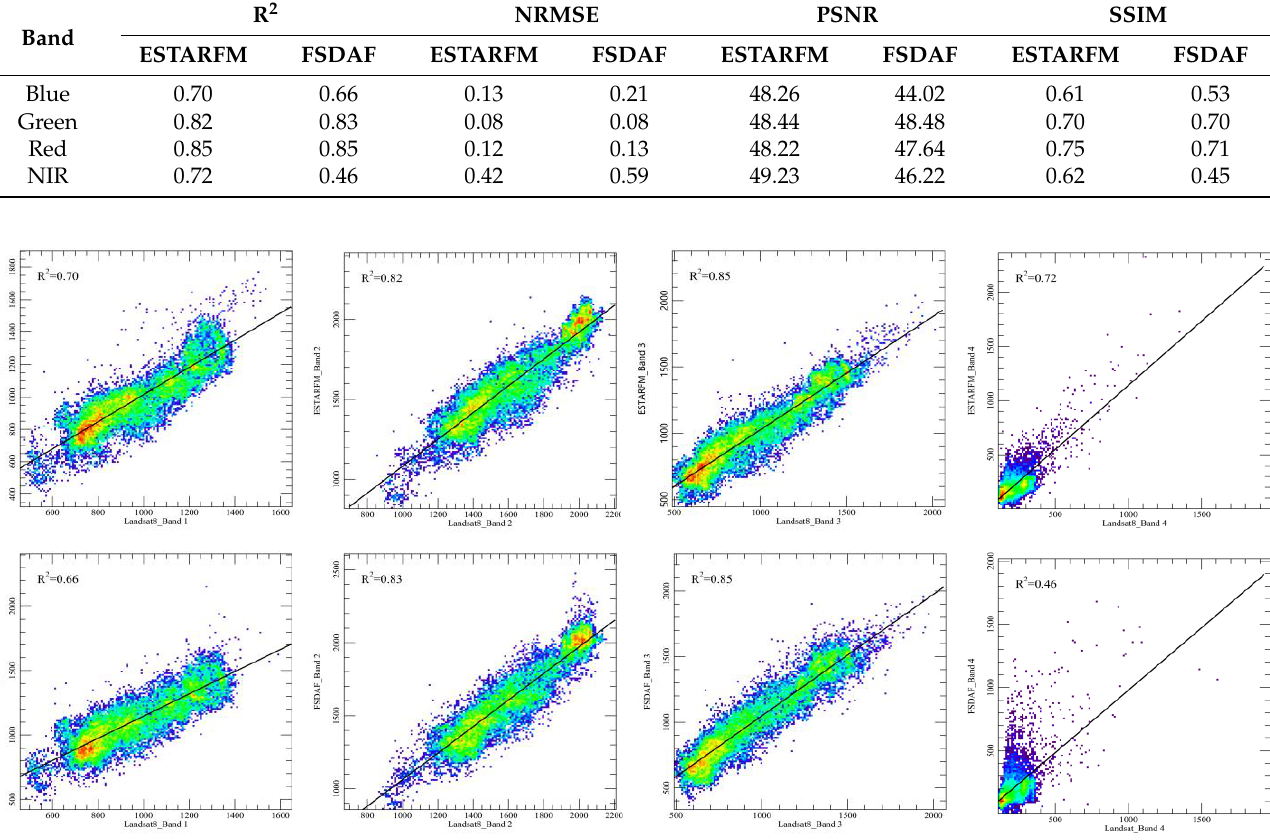
Figure 5. Scatter plots of the coefficient of determination (R 2 ) for blue, green, red, and NIR bands of the ESTARFM and FSDAF fusion